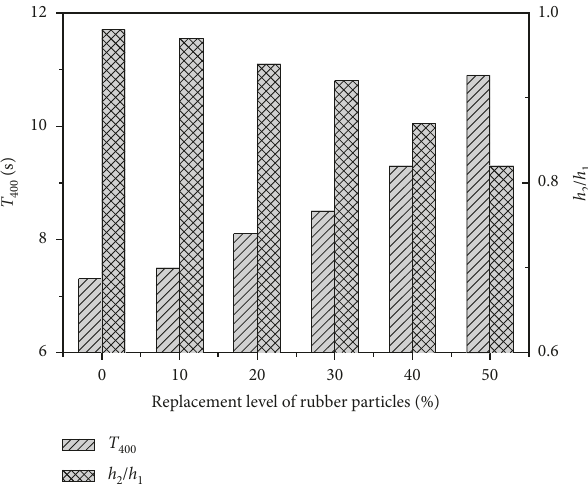
Figure 16: Influence of the replacement level of rubber particles on T 400 and h 2 / h 1